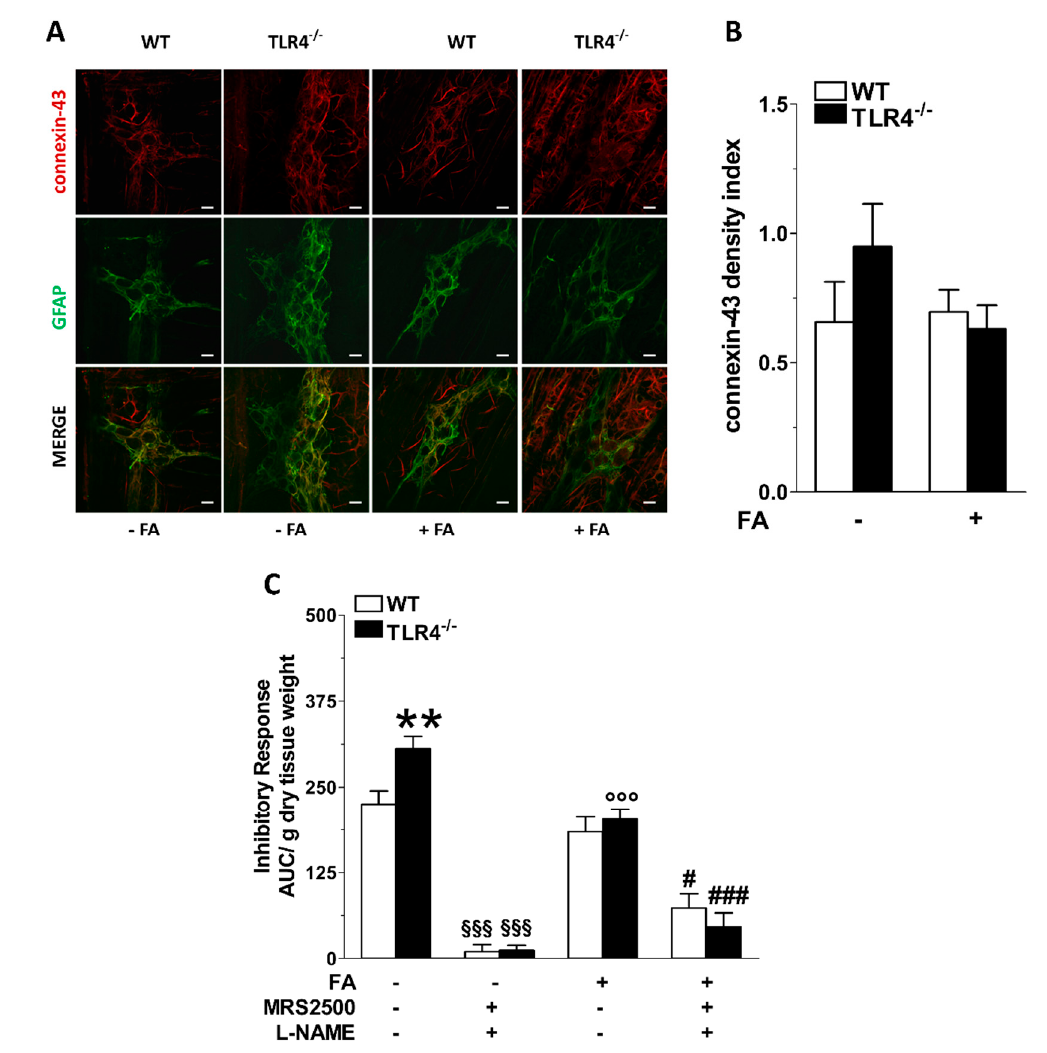
Figure 6. TLR4 signaling and EGC activity regulate nitrergic- and purinergic-mediated inhibitory response of the small intestine. ( A ) Representative confocal microphotographs showing the distribution of connexin-43 (red) and GFAP (green) and ( B ) analysis of connexin-43 density index in ileal LMMPs of WT and TLR4 − / − mice in the presence or absence of 10 µ M FA (bars = 22 µ m). ( C ) 10 Hz EFS-evoked relaxation in NANC conditions with or without 10 µ M FA or 10 µ M MRS2500 (P2Y1R inhibitor) or 1 µ M L-NAME (pan-NOS inhibitor) in WT and TLR4 − / − mice. Data are reported as mean ± SEM for all panels. ** P < 0.01 vs. WT; ◦◦◦ P < 0.001 vs. respective control without FA; §§§ P < 0.001 vs. respective control without MRS2500 and L-NAME. # P < 0.05, ### P < 0.001 vs. respective control with FA and without MRS2500 and L-NAME; N = 6 mice /